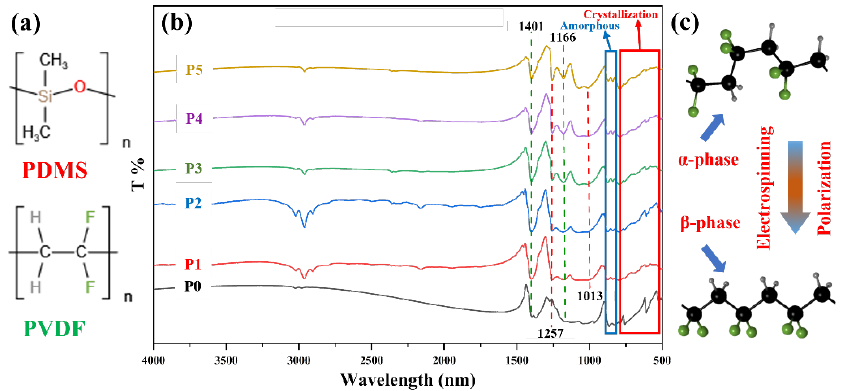
Figure 4. FTIR of different membranes and the principle of PVDF phase transition. ( a ) The structural formulae of PDMS and PVDF. ( b ) FTIR of the membrane. ( c ) The principle of PVDF transformation from α phase to β phase under the high voltage polarization of electrospinning.